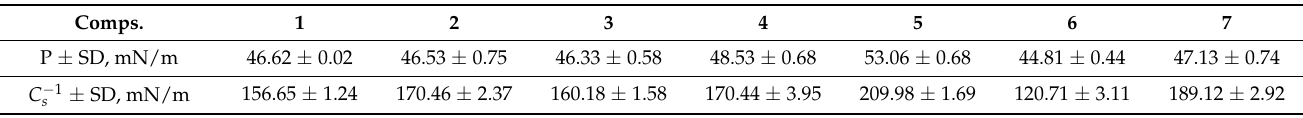
Table 2. Mechanical properties of monolayers composed of 1,4-DHP amphiphiles 1 – 7 . P (mN/m) is the critical pressure of the monolayers; C − 1 s mN/m) is the compressibility modulus.